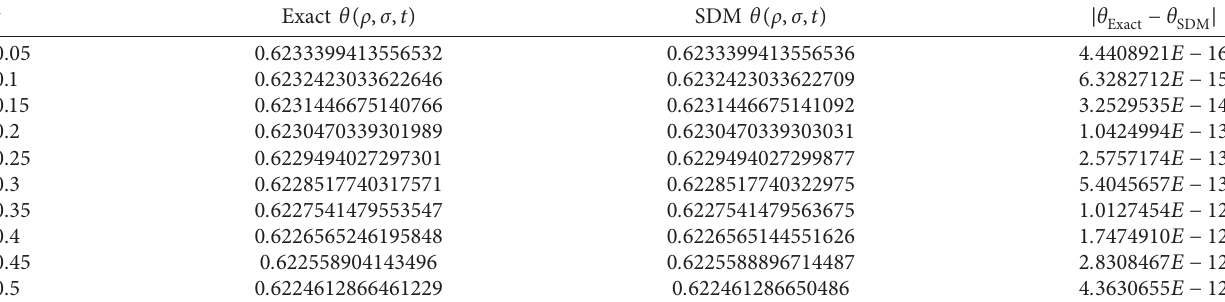
Table 3: The (SDM) results for θ ( ρ , σ , t ) , for first four approximations, and for R � 1, with mesh points ρ � 0.3 and σ � 0.1, for Example